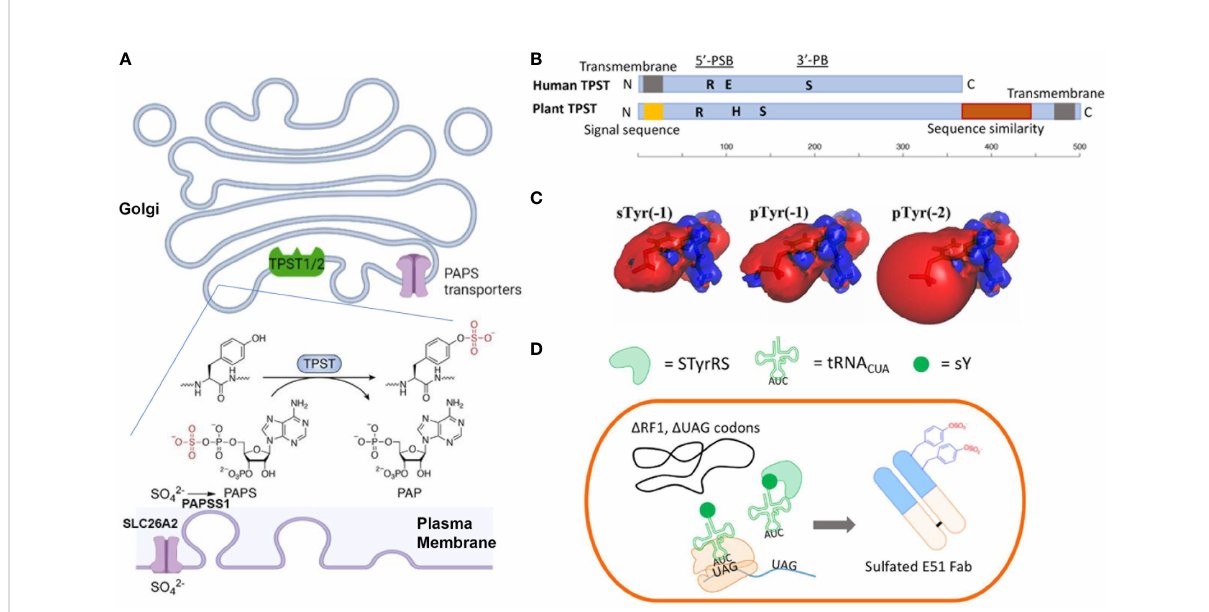
FIGURE 1 (A) Mechanisms of Tyr-sulfation in mammalian cells. (B) Primary structures of human TPST and plant TPST (25, 26) (created with BioRender.com). Conserved residue Lys (R) in 5 ’ -PSB, Ser (S) in 3 ’ -PB, and catalytic base residue His (H) and Glu (E) are depicted. (C) Comparison of electrostatic potentials for sTyr, pTyr (-1) and pTyr (-2) (27). (D) Production of sTyr-containing Fab with extended genetic codon technologies